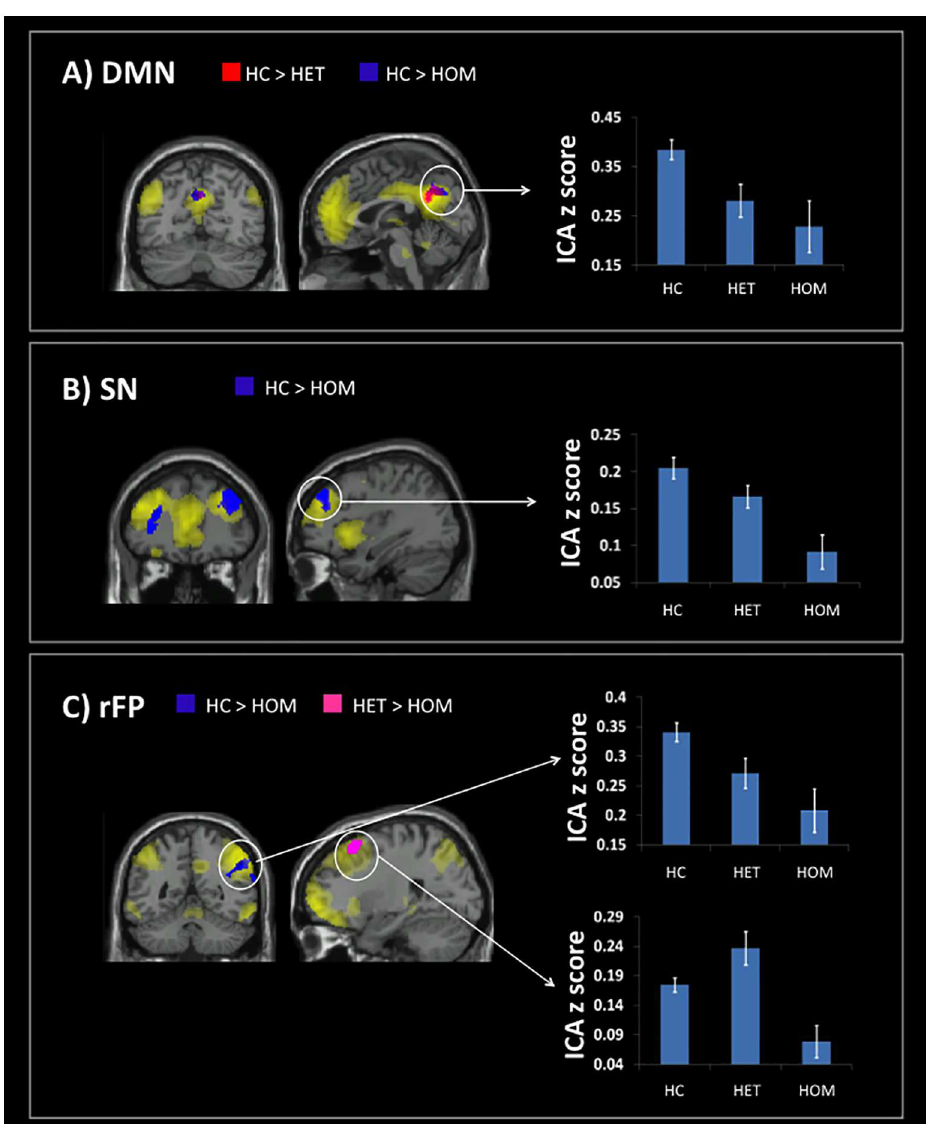
Fig 1. Between group FC changes within the RS-fMRI networks of interest. This figure illustrates between-group differences in functional brain connectivity observed in individual networks: A) the default mode network (DMN), B) the executive network (ExN), and C) the right fronto-parietal network (rFP). In all cases, the networks (main effect of groups) are shown in yellow. Red areas show the regionalpattern of reducedconnectivity in homozygous mutation carriers (HOM) as compared to healthy controls (HC). Blue areas show the regionalpattern of reduced connectivity in heterozygous mutation carriers (HET) as compared to HC. Pink areas show the regionalpattern of reducedconnectivity in HOM as compared to HET. For each contrast, the signal plots on the right show the group level of connectivity at the peak of some